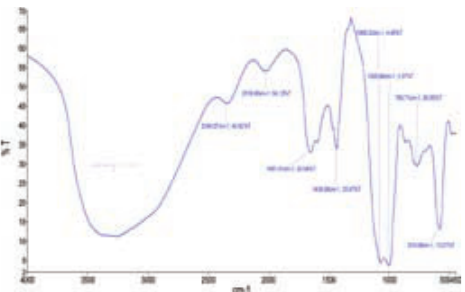
Figure 6: Infrared spectrum from goat A 1 showing struvite bands at 3391, 1434, 2331, 1650 and 1000.4 cm -1